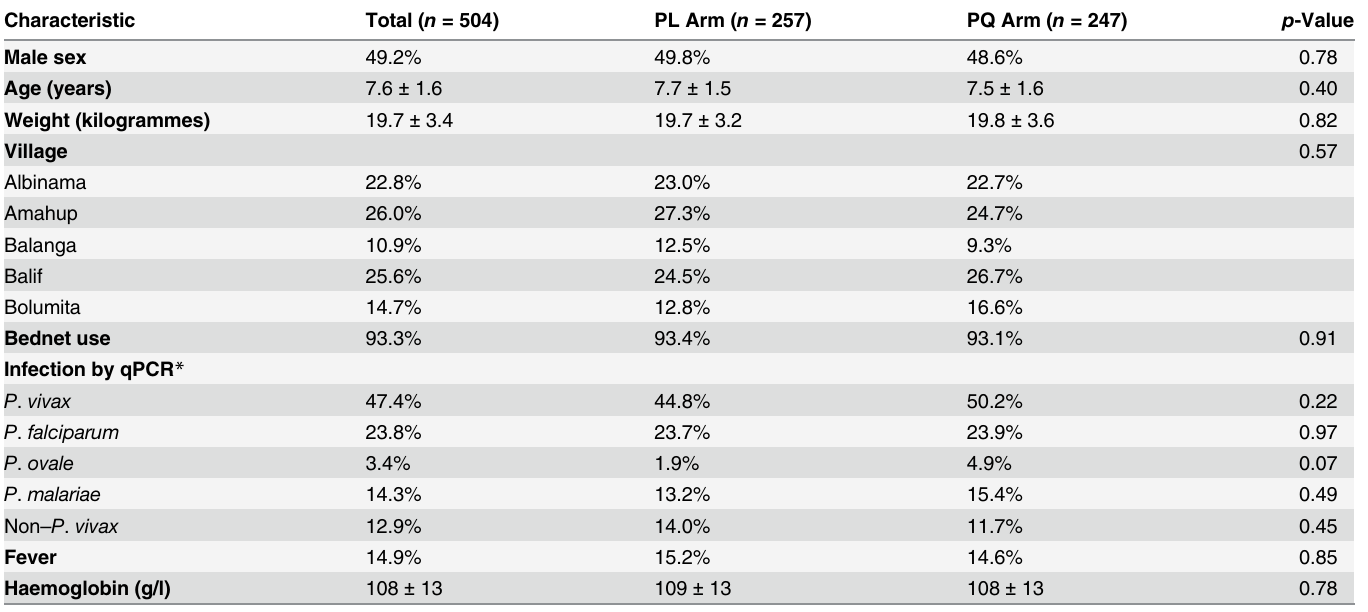
Data are percentage or mean ± standard deviation. Analysis is by chi-square and Fisher ’ s exact tests for categorical characteristics and Student ’ s t -test for normally distributed continuous